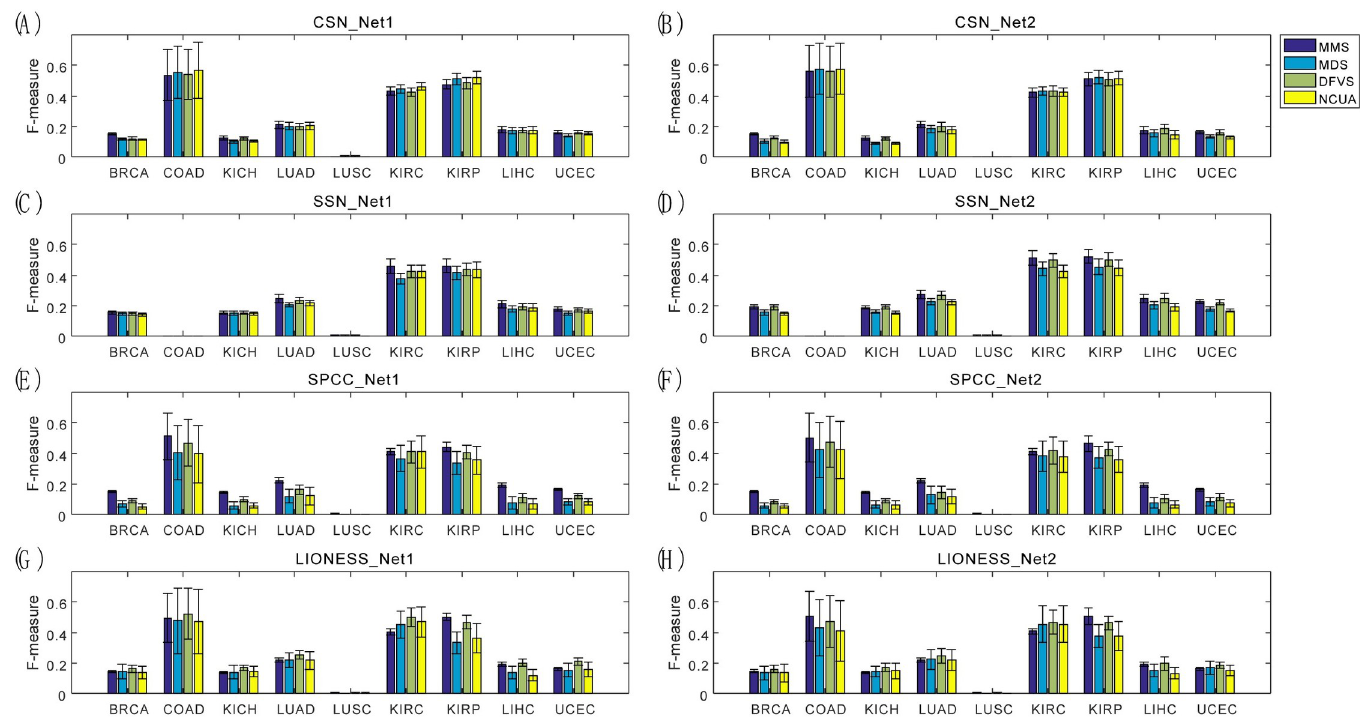
Fig 8. Identification of “dark-differential expression genes” by different SSC workflows on multiple TCGA cancer expression datasets. The different state transition networks includes (A) CSN_Net1, (B) CSN_Net2, (C) SSN_Net1, (D) SSN_Net2, (E) SPCC_Net1, (F) SPCC_Net2, (G) LIONESS_Net1, and (H) LIONESS_Net2.